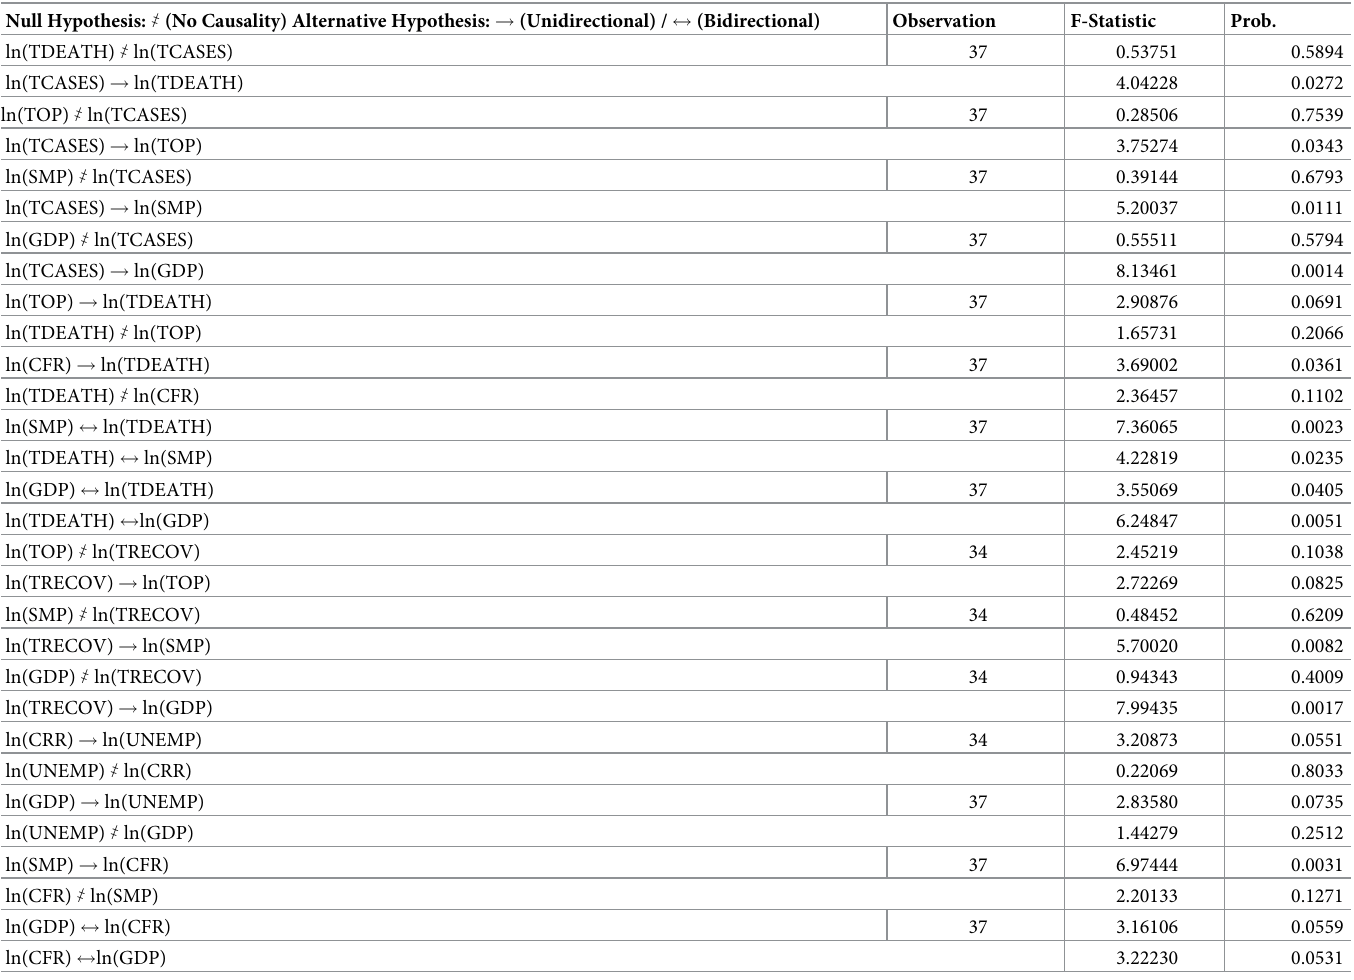
Table 6. VAR Granger causality